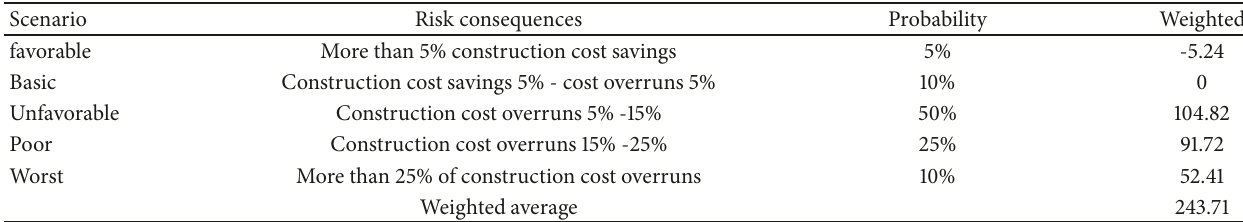
Table 5: The estimated investment risks scenario of probabilistic methods, unit: million Yuan.